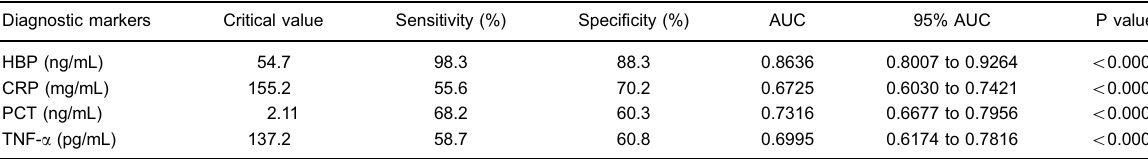
Table 2. Levels of HBP, CRP, PCT, and TNF- a for the diagnosis of purulent meningitis. Diagnostic